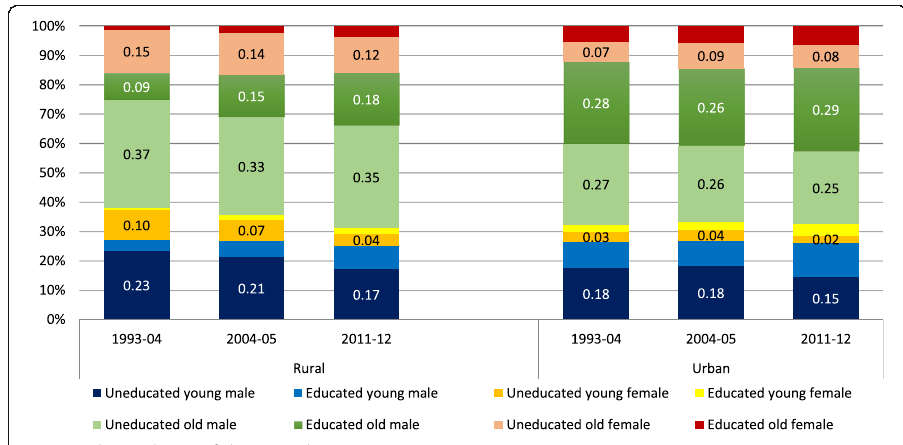
Fig. 1 Relative shares of demographic groups among wage